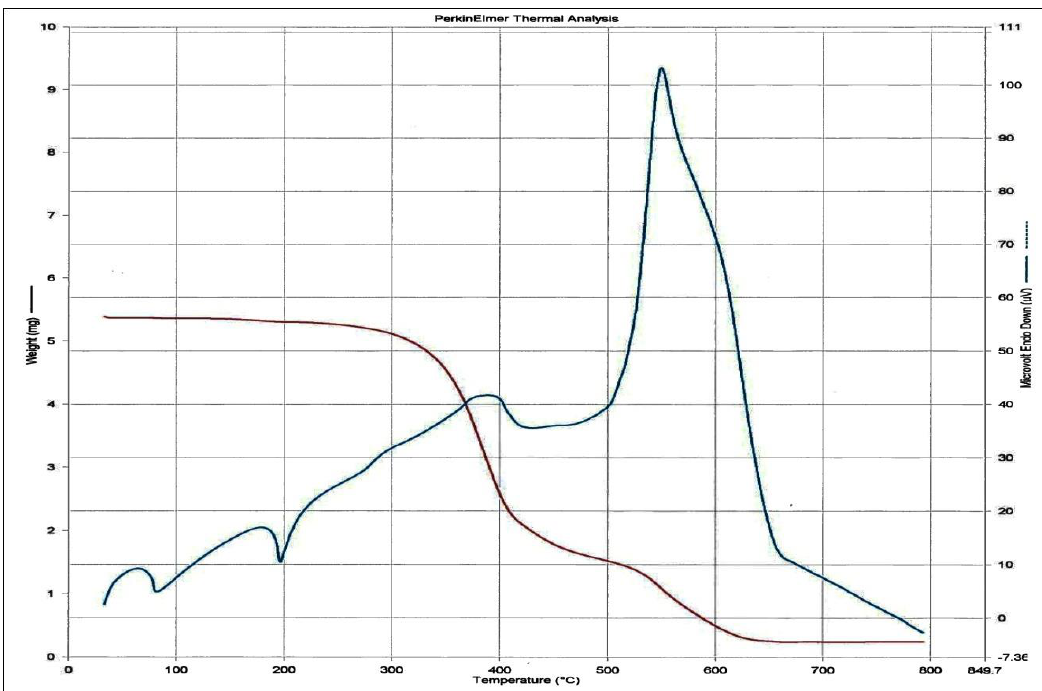
Figure S24: TG/DTA graph of dialdehyde monomer o